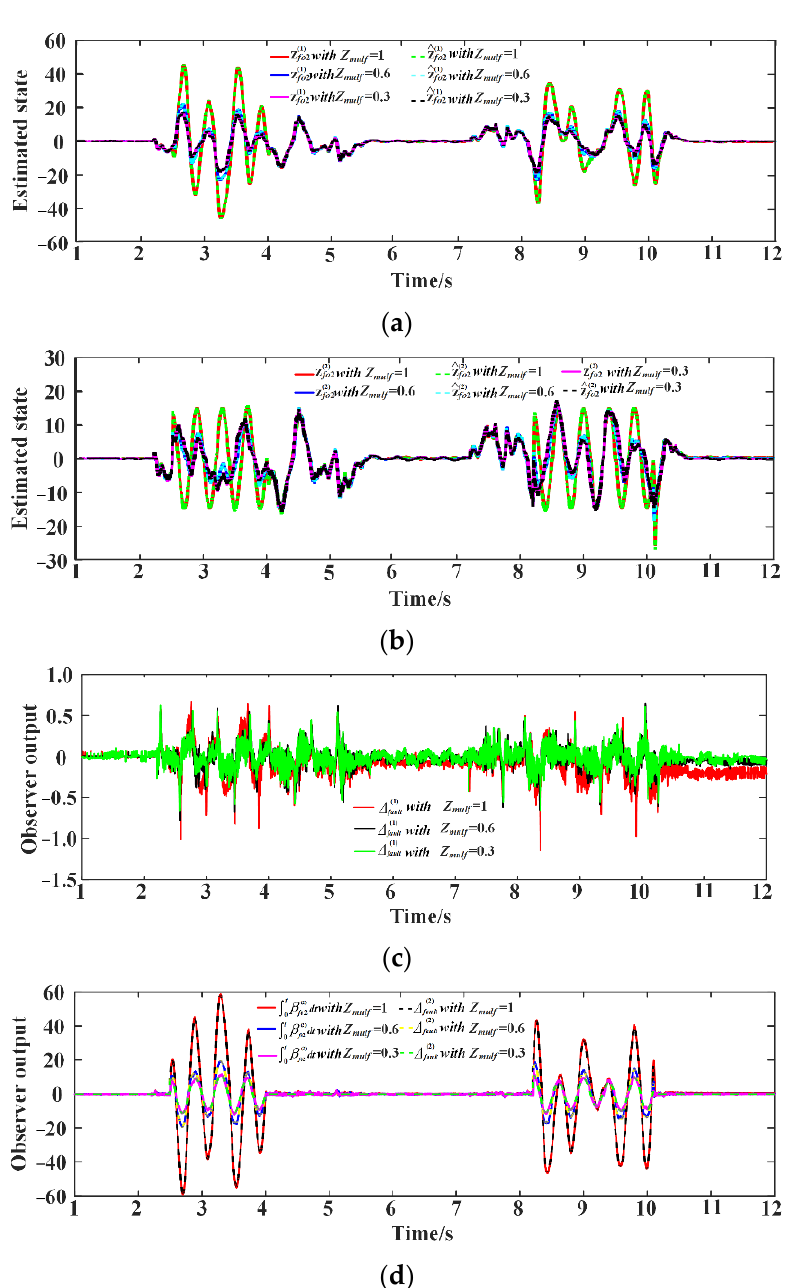
Figure 9. Fault observer output under fault conditions: ( a ) Estimated state of left actuator; ( b ) Esti- mated state of right actuator; ( c ) Fault estimation output of left actuator; ( d ) Fault estimation output of right